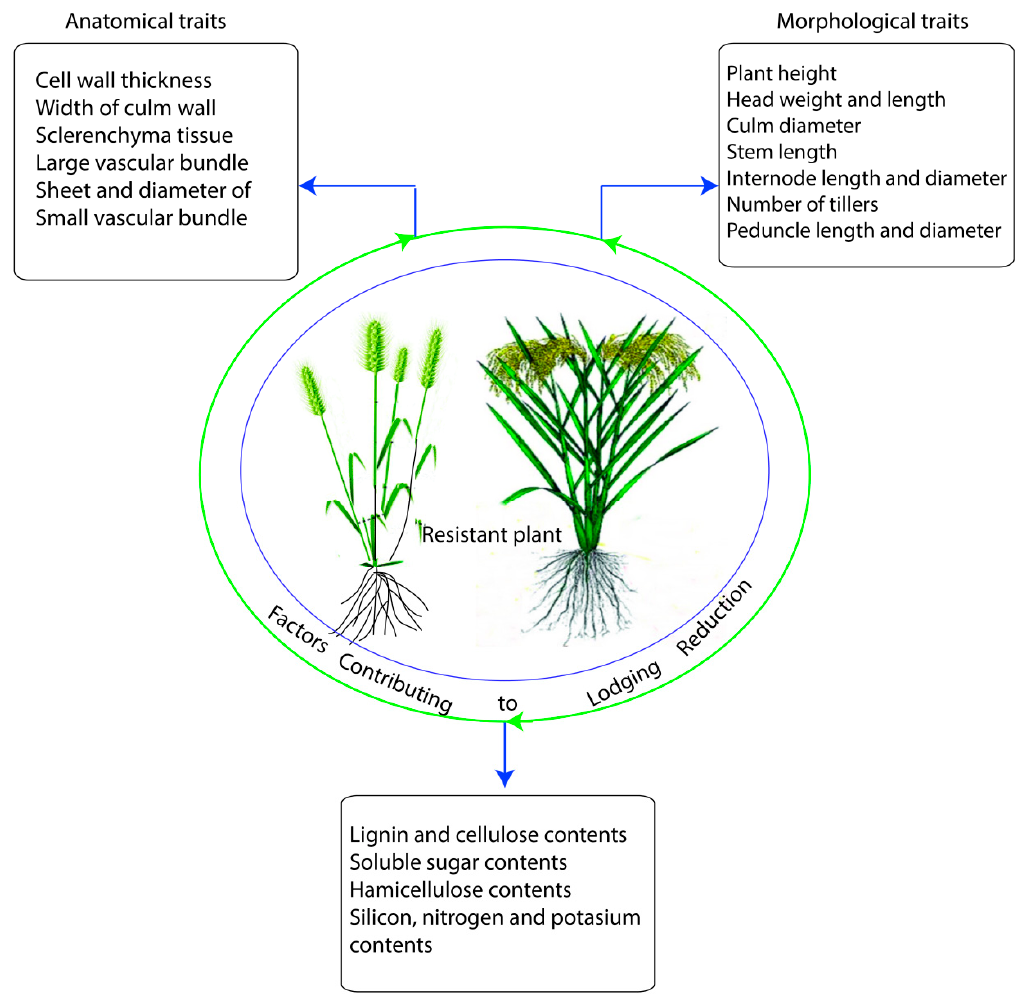
Figure 1. Major traits associated with the reduction of lodging in wheat and rice. Factors associated with the lodging resistance are shown by (blue) arrows, whilst resistant plants through these contributing elements are encircled in (green) arrows.